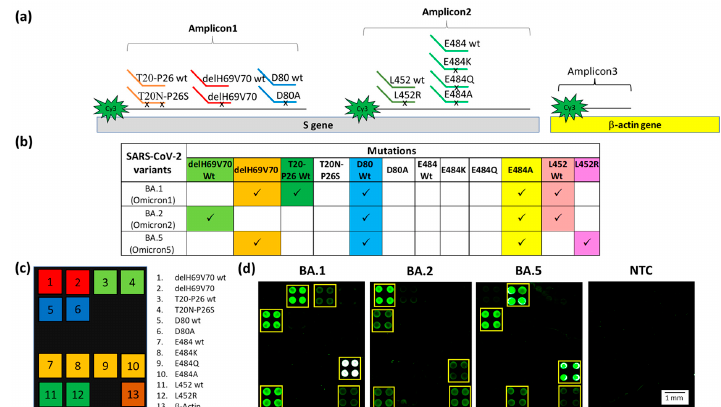
Figure 4. ( a ) Schematic representation of the Dual-domain reporters used in the assay and the Cy3 labeled strands generated in the PCR multiplex assay. A small black x on the discriminating domain of the Dual-domain reporters indicates the presence of the mutations. The human β -actin amplicon (Amplicon3) hybridizes directly to the capture probe bound to the microarray surface. ( b ) Specific mutations signature for the Omicron BA.1, BA.2 and BA.5 sub-variants. The mutations detected in the assay are shown in the columns and sub-variants are shown in the rows. Each of the Omicron sub-variants can be identified by a specific pattern of mutations combination. ( c ) The spotting schema of the array. ( d ) Cy3 fluorescence image of four silicon chips. Each chip is hybridized with a triplex Cy3-labeled PCR (Amplicon1, 2 and 3) from samples carried the BA.1, BA.2, BA.5 sub-variants and a No Template Control (NTC) with no DNA, incubated with the whole set of Dual-domain reporters. The yellow squares in the images were used to highlight more easily the spots corresponding to the presence of hybridization. The spots are 400 μ m large with a pitch of 800 μ m.